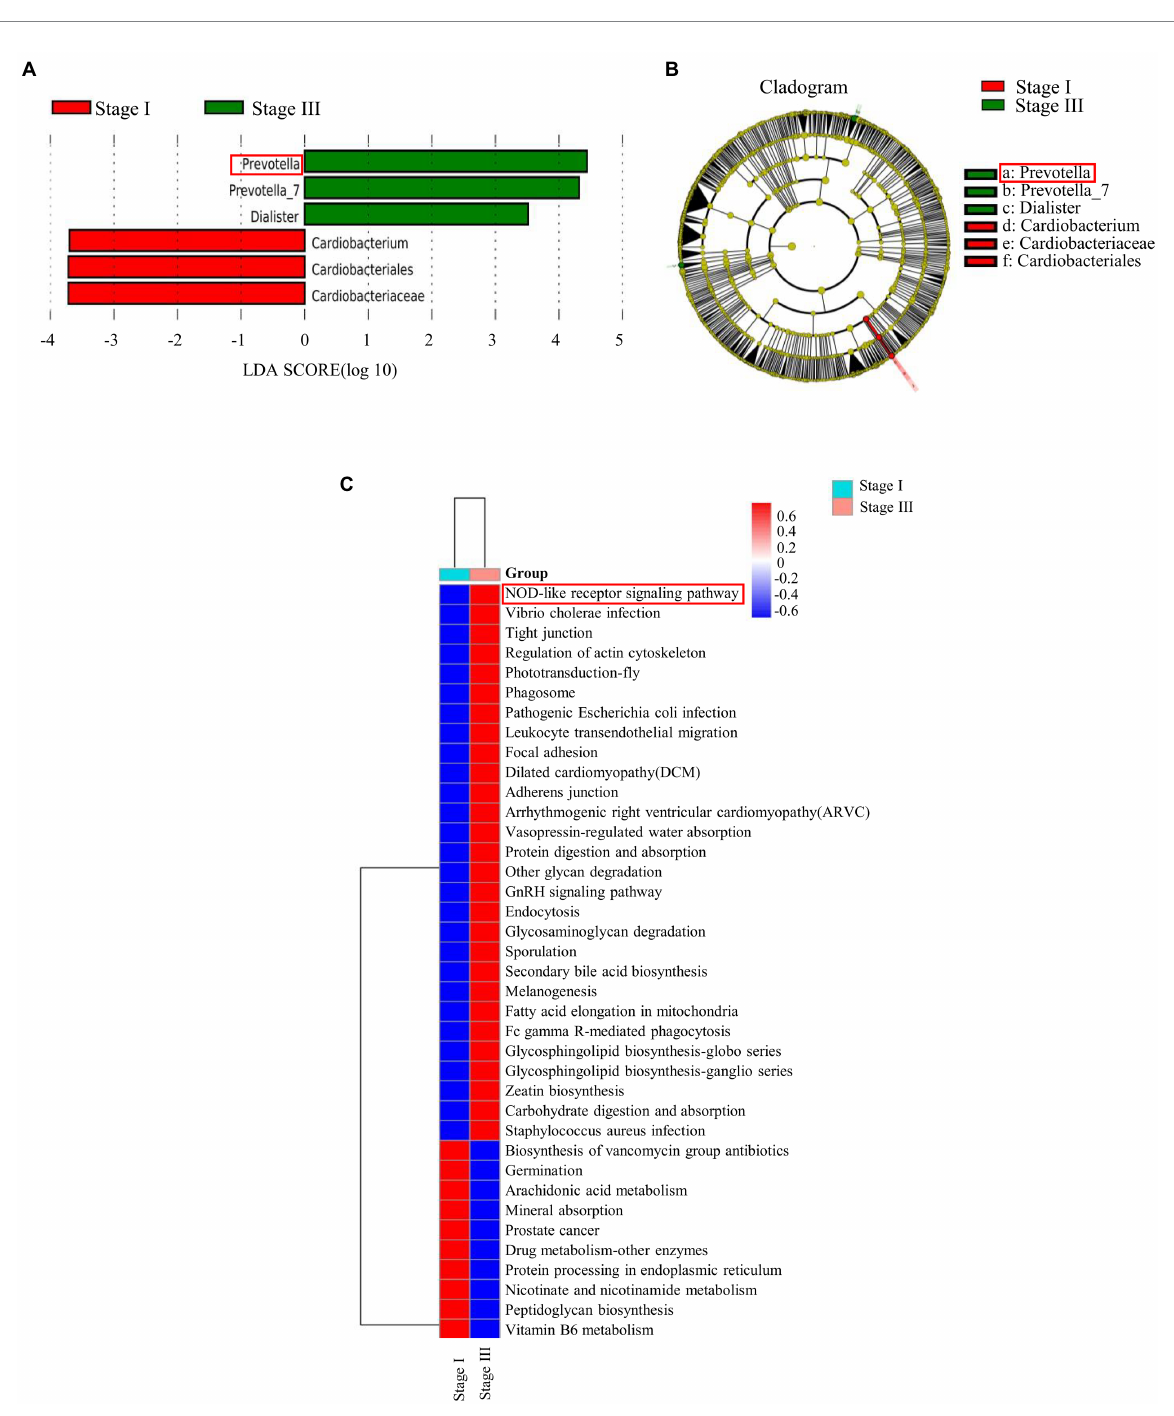
FIGURE 4 The linear discriminant analysis effect size (LEfSe) results of oral microbiomes in different groups, and pathway enrichment analysis based on the Kyoto Encyclopedia of Genes and Genomes (KEGG). (A) Histogram of the comparison of linear discriminant analysis (LDA) score analysis between stage I and stage III samples. Samples of stage I periodontitis-enriched taxa are indicated with a positive LDA score (green), while taxa enriched in samples of stage III periodontitis have a negative score (red). (B) Taxonomic cladogram obtained from linear discriminant analysis effect size analysis. The cladogram reports the taxa (highlighted by small circles and by shading; red indicates samples of stage I periodontitis, green indicates samples of stage III periodontitis, and yellow indicates non-significant results) showing different abundance values. (C) The differences between all samples of stage I and stage III periodontitis were clustered into a heatmap at the L3 level of